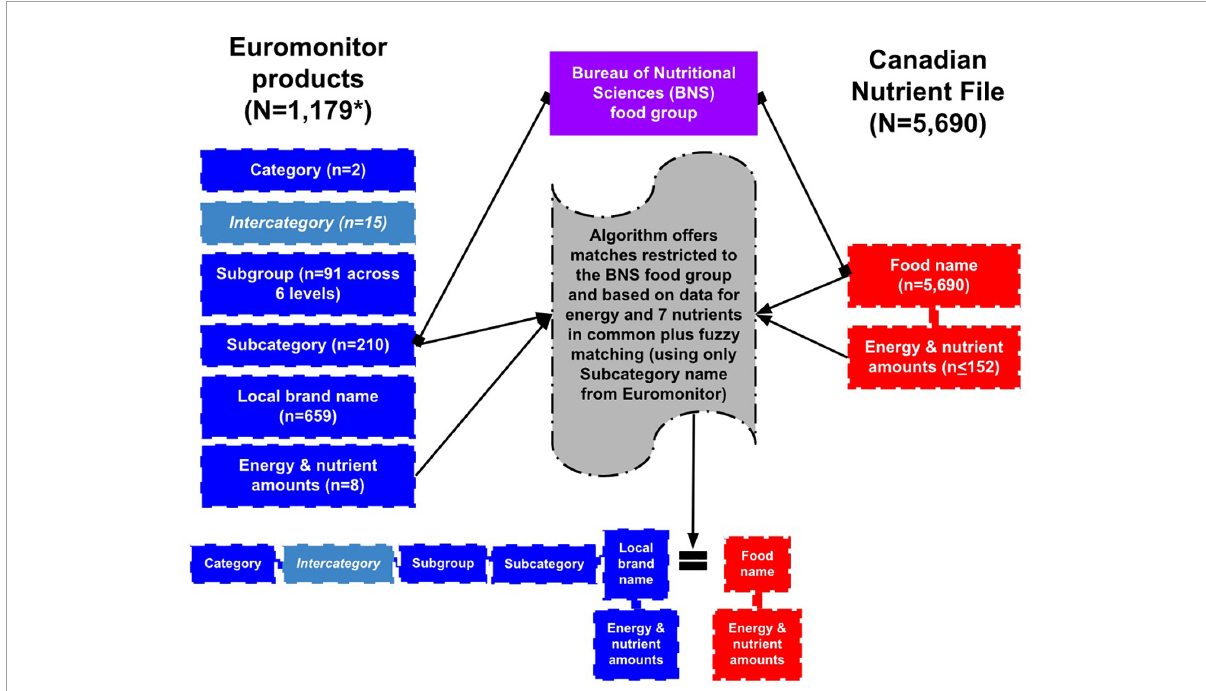
FIGURE1 Overview of the architectures of Euromonitor’s Canadian data subset in Passport Nutrition and the Canadian Nutrient File (CNF), with an emphasis on the key variables used in their database mapping. *Of the 1,179 total Euromonitor products, only 1,111 were ultimately able to be run through the